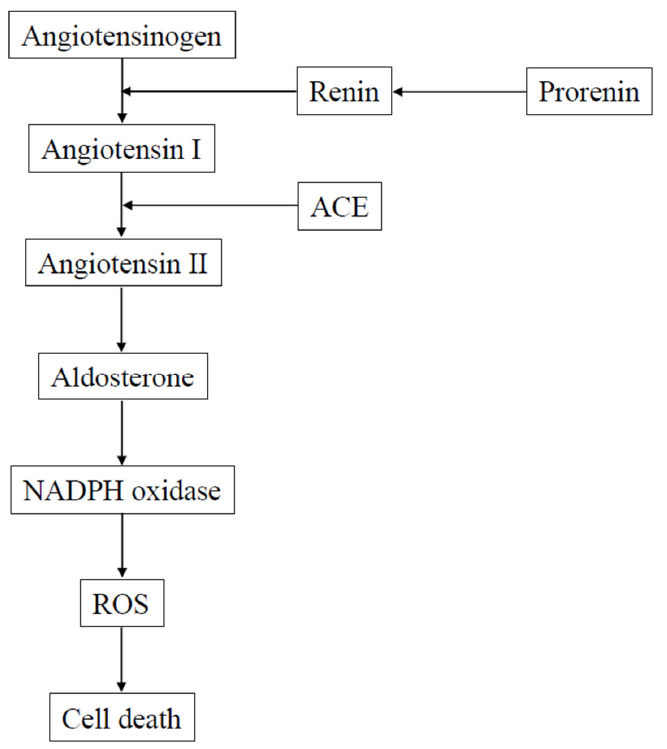
Figure 1. Possible mechanism of retinal neuronal cell death. After activation of the renin-angiotensin-aldosterone pathway, the production of reactive oxygen species in the retina is mediated via an NADPH oxidase pathway. ACE, angiotensin converting enzyme; ROS, reactive oxygen species.